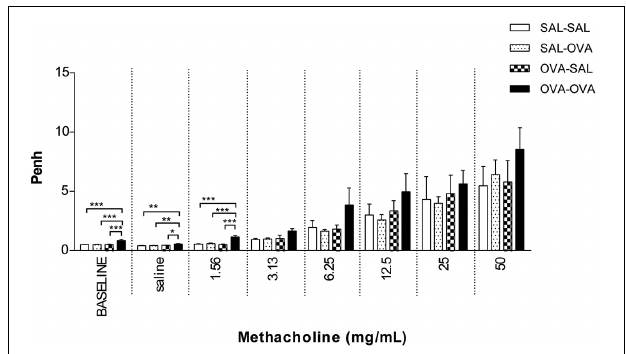
FIGURE 4 | Airway responsiveness (Penh) to methacholine in the severe airway inflammation model. Airway responsiveness was measured in mice sensitized with saline or TNP-OVA and challenged intranasally with saline or TNP-OVA-IgE. Values are expressed as mean ± s.e.m. ∗ P < 0 . 05, ∗∗ P < 0 . 01, ∗∗∗ P < 0 . 001; using a One-Way ANOVA followed by a Bonferroni post-hoc analysis, n = 7–9